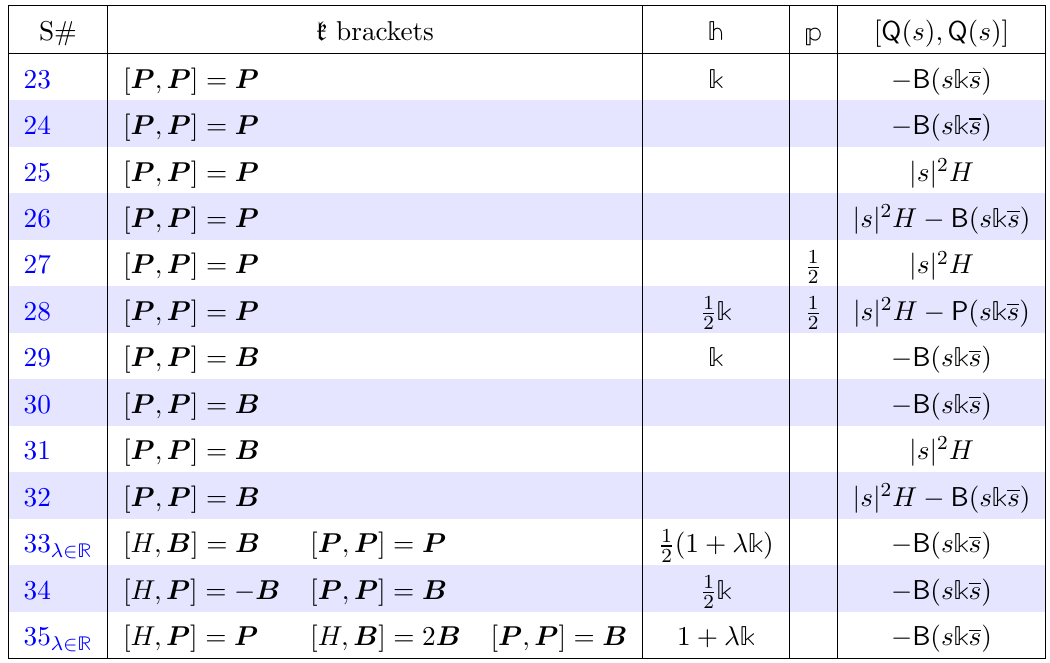
Table 11 . More super Lie pairs (with V = P